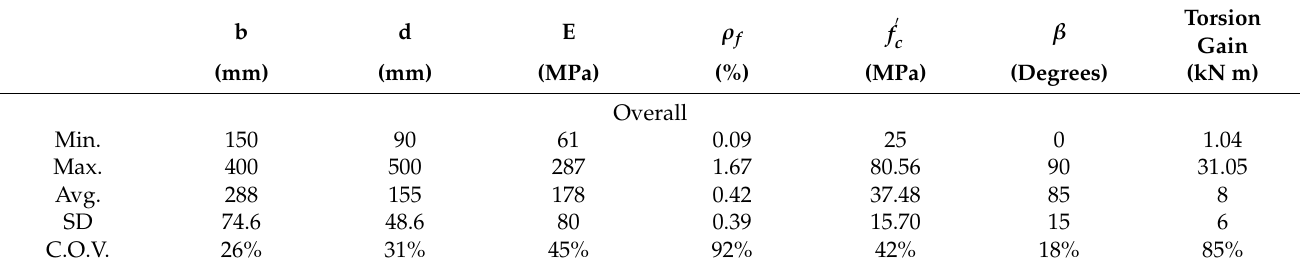
Table 1. Statistical analysis of experimental